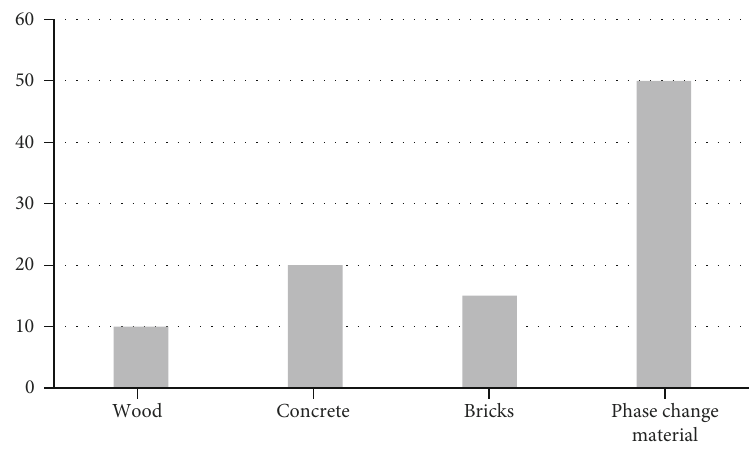
Figure 7: Density of energy